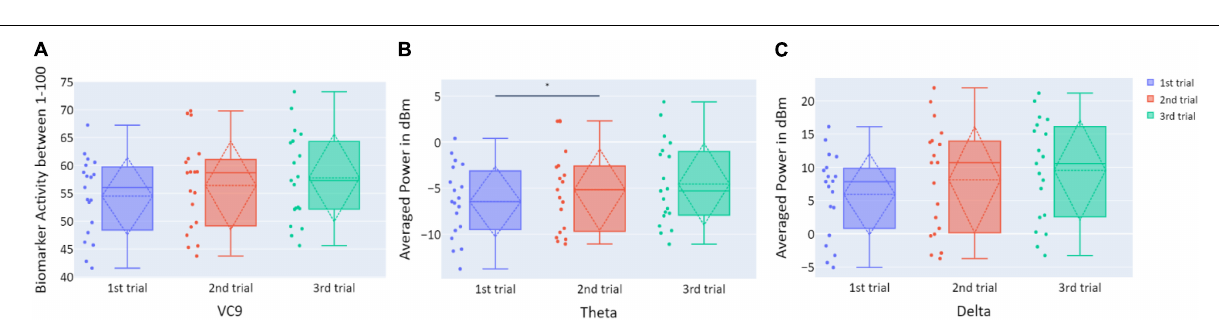
FIGURE 10 | (A) The distribution of user VC9 activity (normalized between 1 and 100); (B) the distribution of theta (averaged power of 4–7 Hz in dBm); and (C) the distribution of delta (averaged power of 0.5–4 Hz in dBm), obtained in the three trials of Experiment 3, as a function of task repetitions: first trial (blue), second trial (red), and third trial (green), for all participants ( n = 19). Dashed lines represent means and SDs. ∗ p < 0.05, ∗∗ p < 0.01, and ∗∗∗ p <